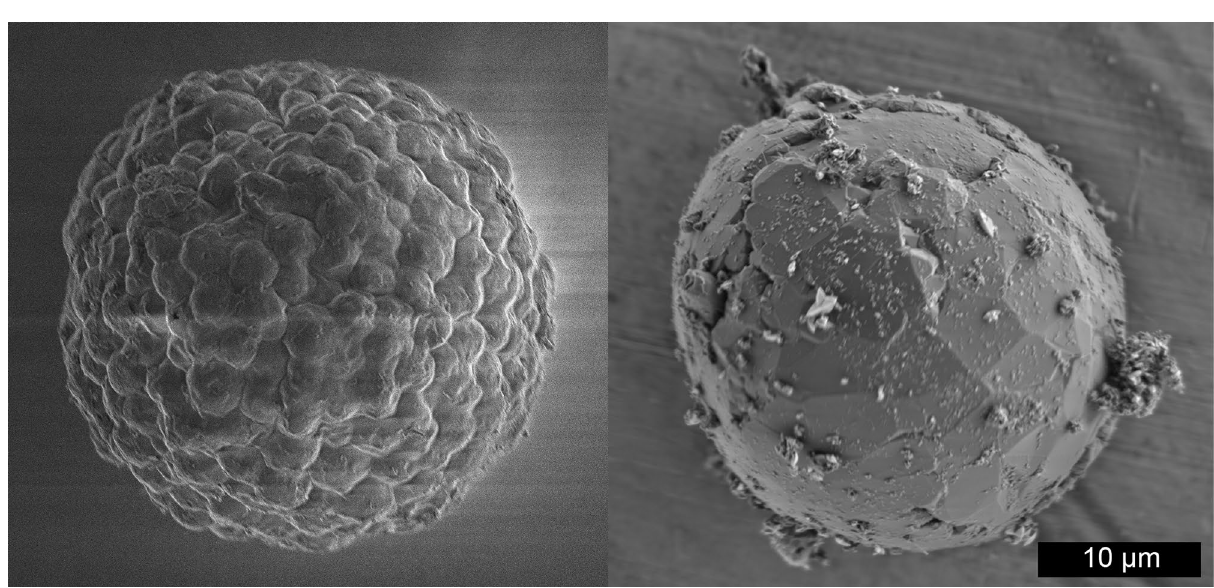
Figure 3. SEM images of sawdust char (left) and BCG made from sawdust char (right) showing preservation of wood-like morphology during graphitization.